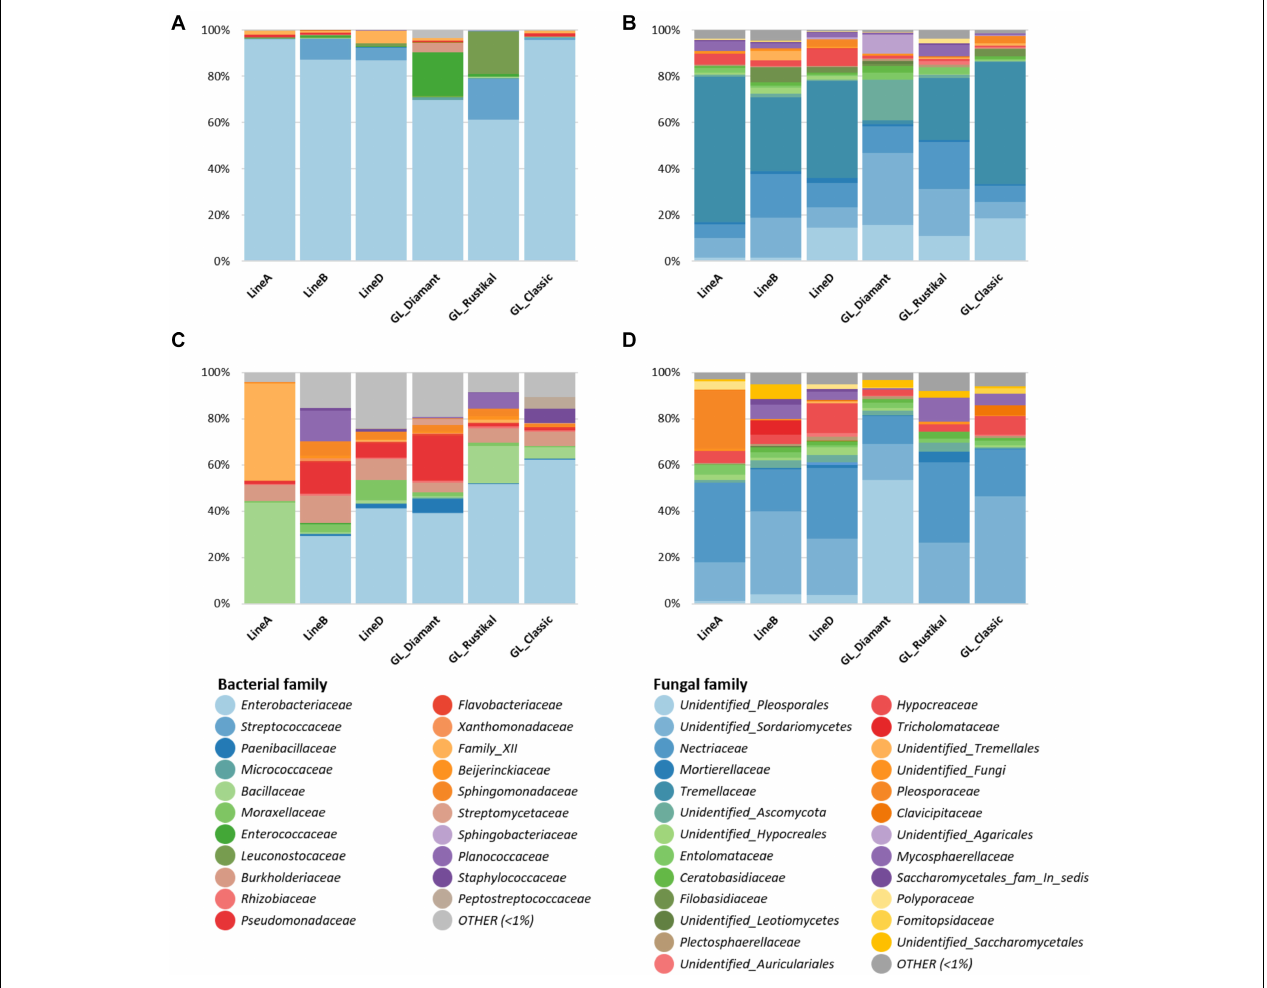
FIGURE 3 | Relative taxonomic composition of seeds from different genotypes [sown seeds (A,B) and progeny seeds (C,D) ]. Bacterial (A,C) and fungal (B,D) taxa above 1% relative abundance on family level are shown. Low-abundance taxa ( < 1%) are summarized as